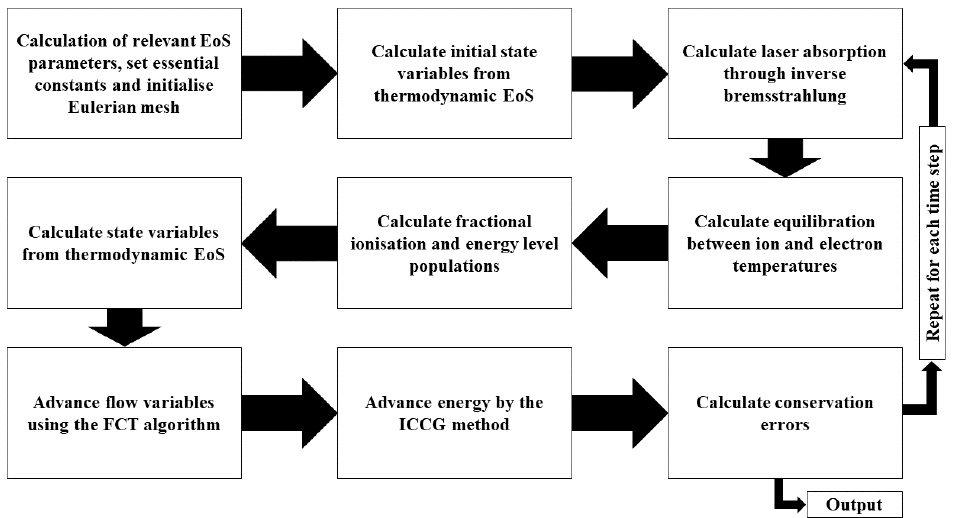
Figure 1. Flowchart summarising the POLLUX